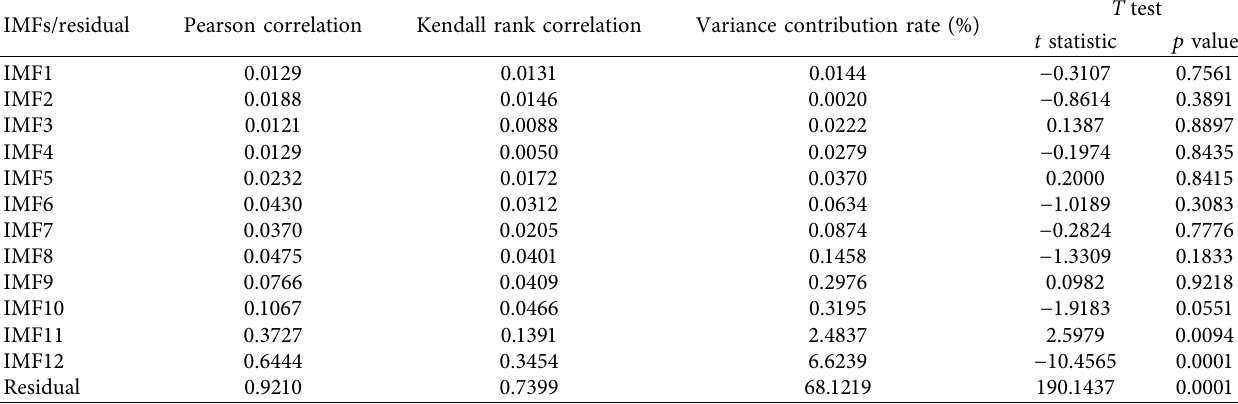
Table 3: Correlation coefcient, VCR, and T test results for each IMF and the residual.